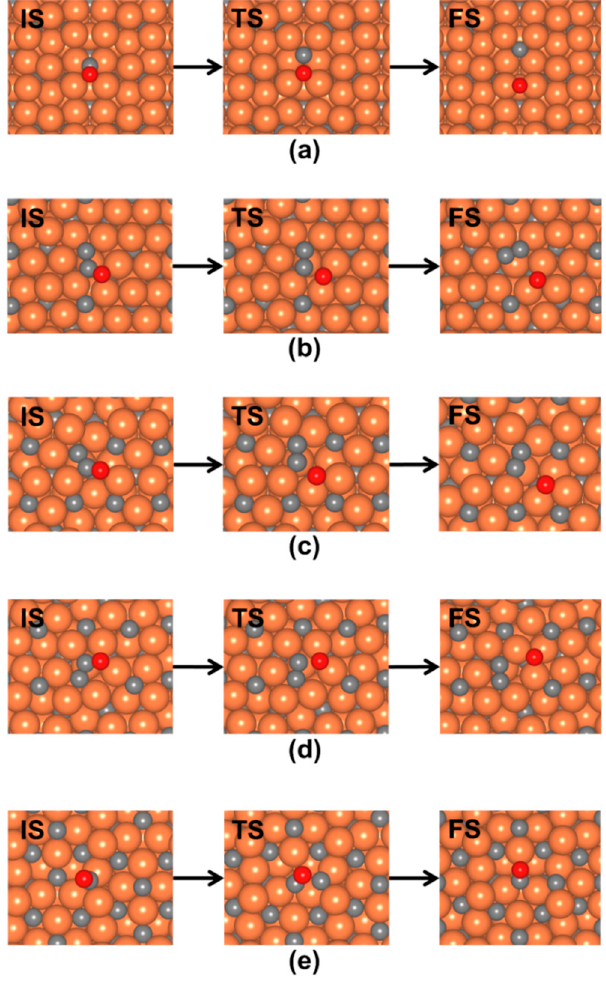
Figure 4. Top views of initial (IS), transition (TS), and final states (FS) for CO* dissociation on o-Fe 7 C 3 (001) surfaces with different terminations. The images were obtained from the NEB calculations: ( a ) (001) 0.85 , ( b ) (001) 0.13 , ( c ) (001) 0.20 , ( d ) (001) 0.09 , and ( e ) (001) 0.99 . Orange, gray, and red balls in the figure represent Fe, C, and O, respectively.